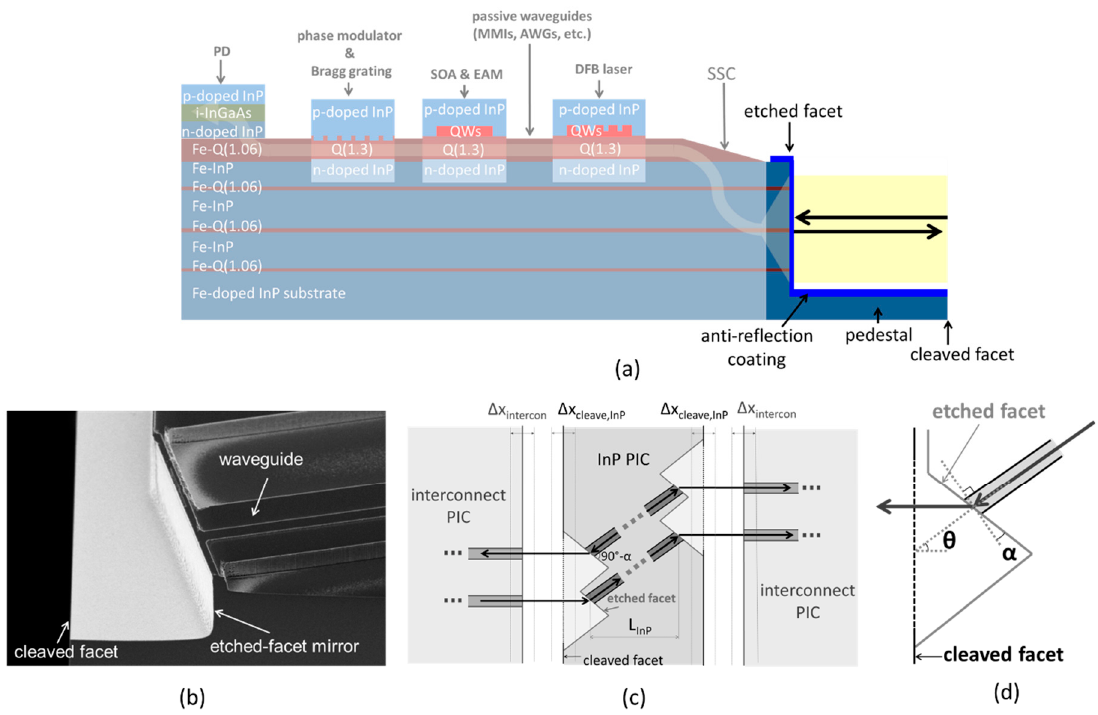
Figure 8. Schematic showing the implementation of etched facets on the generic-foundry process ( a ). SEM photograph of a diluted waveguide with an etched facet near a cleaved facet ( b ), a top view schematic of the coupling between an InP PIC and an interconnect PIC ( c ), and an illustration of the parameters involved in defining the required etched-facet properties ( d ).